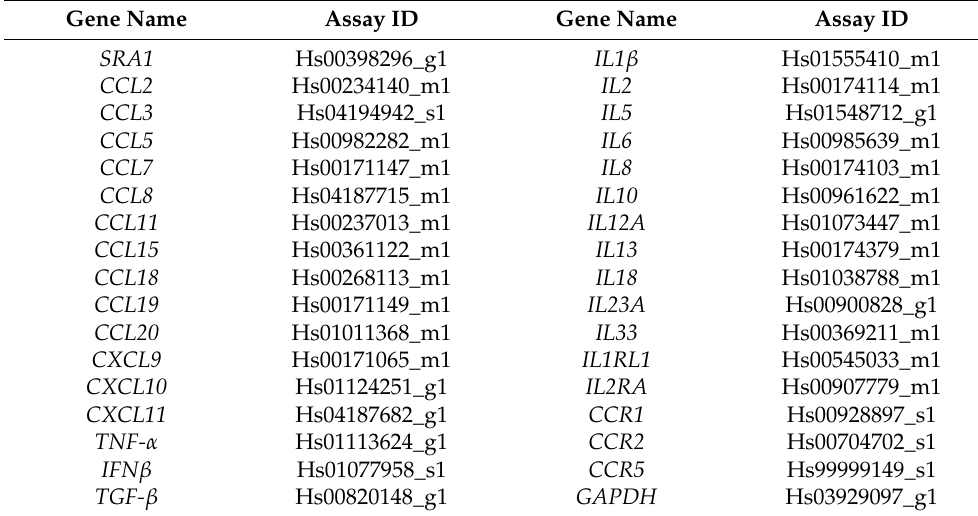
Table 1. List of TaqMan gene expression